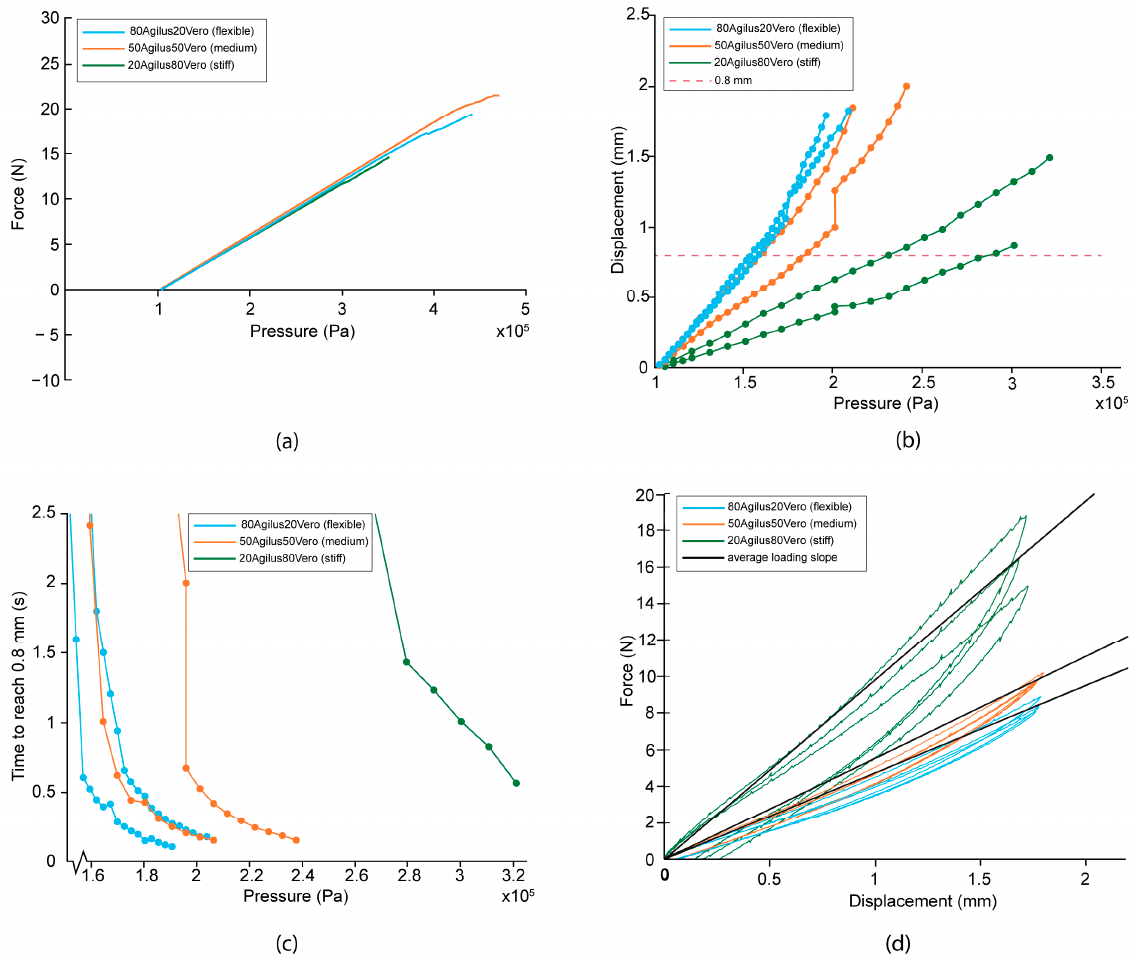
Figure 9. Test results of the digital material diaphragms. ( a ) The average forward force as a function of the pressure. ( b ) The displacement of the carrier as a function of the pressure. Only two prototypes for each material could be tested due to failure. ( c ) The time it took the carrier to reach a forward displacement of 0.8 mm as a function of different pressure levels. Only two prototypes for each material could be tested due to failure for the medium and stiff materials. Only one of the stiff prototypes (20Agilus80Vero) is plotted, and the other prototype failed during the test. ( d ) The loading and unloading curves of the prototypes, illustrating the hysteresis present in the mechanism.